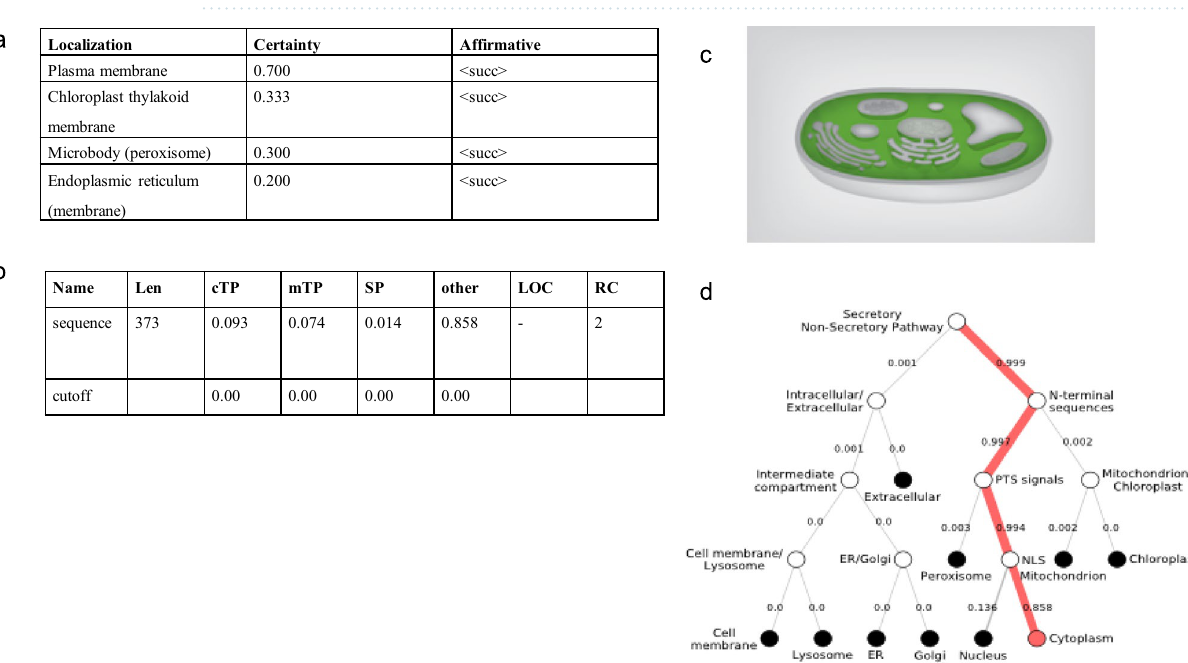
Figure 3. The representation of hydrophobic–hydrophilic patterns in GsPUB8 protein by use of Protscale software. The hydrophobic and hydrophilic domains are considered to exist above and below the zero line respectively.